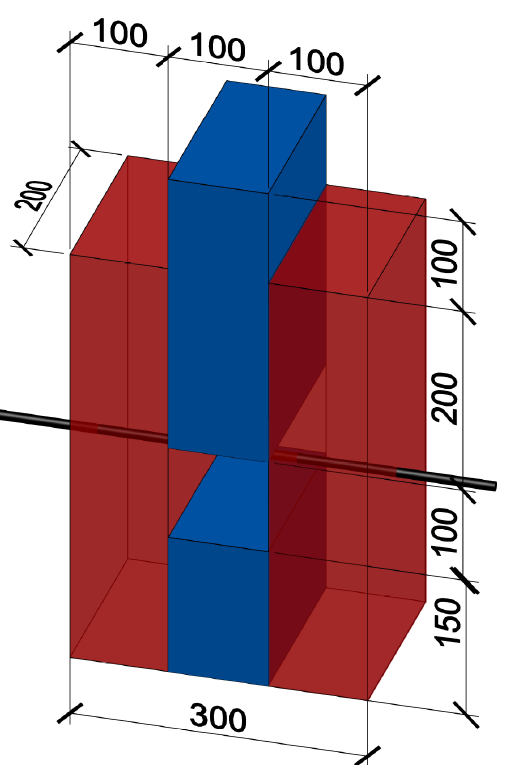
Figure 3. Sandwich specimen, red colour indicates UHPC, blue colour indicates NSC, grey bar is a threaded rod and the empty space between NSC parts is filled with Styrofoam.